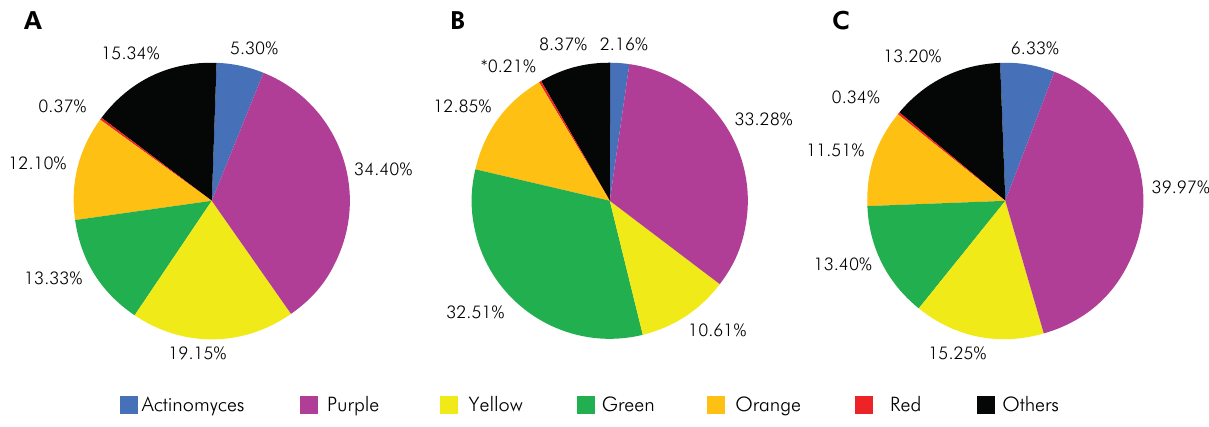
Figure 3. Mean proportions of the bacterial complexes of biofilms formed on titanium discs surfaces of G1, discs with machined surface; (A) G2, discs produced via the additive manufacturing of titanium with chemical treatment (B); and G3, discs produced via the additive manufacturing of titanium without chemical treatment (C). Three independent experiments in triplicate (N = 9) were performed. The colors represent different microbial complexes as described by Socransky et al. (1988). Data were analyzed using the Kruskal–Wallis test, followed by Dunnett post hoc analysis. * indicates significant difference between G1 and G2 (p < 0.05).